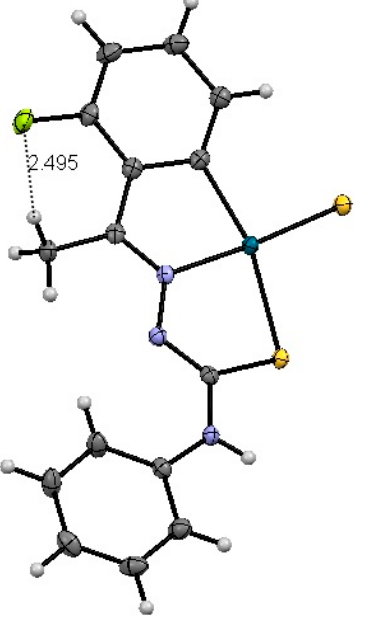
Figure 4. Intramolecular interaction of F(1)-H in compound 4b .